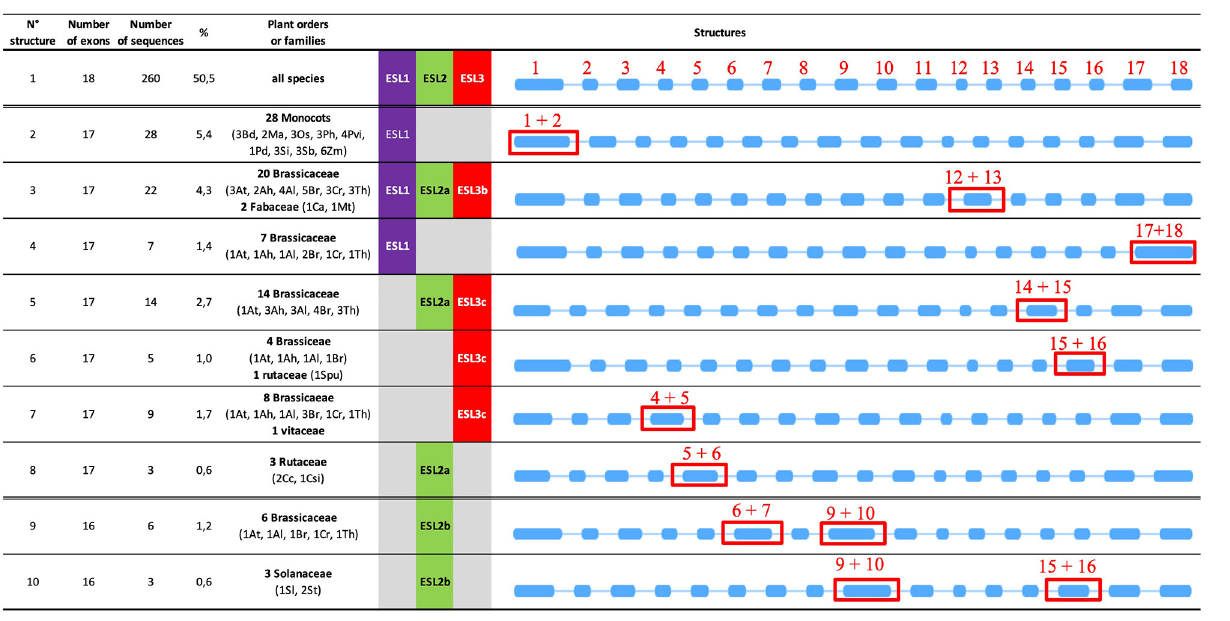
FIGURE 9 | Major types of introns/exons structure identified in ESL genes. The blue rectangles represent the exons and the lines the introns. The introns are represented with a scale that does not take into account their real length. Red numbers indicate the exons and the red rectangles highlight the differences. For each structure, the number of exons and the number of sequences are indicated as well as the percentage of total ESL sequences and the botanical groups in which they have been detected.